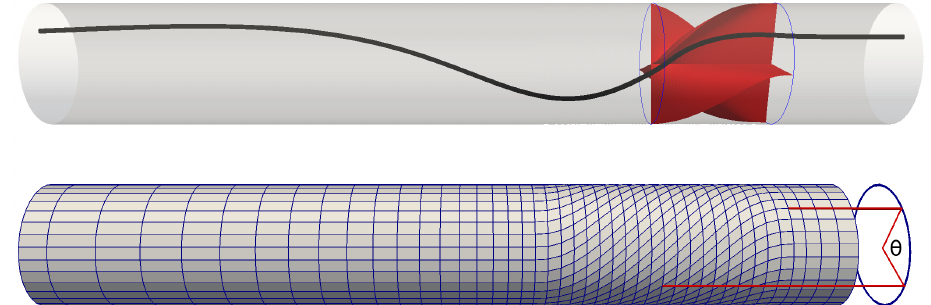
Figure 3. A single streamline flowing from right to left through a swirler ( upper ) for a typical case; as well as the effect of twist angle θ on the mesh ( lower ). The twist angle moves all mesh points on the surface from the upper horizontal red line to the lower one.